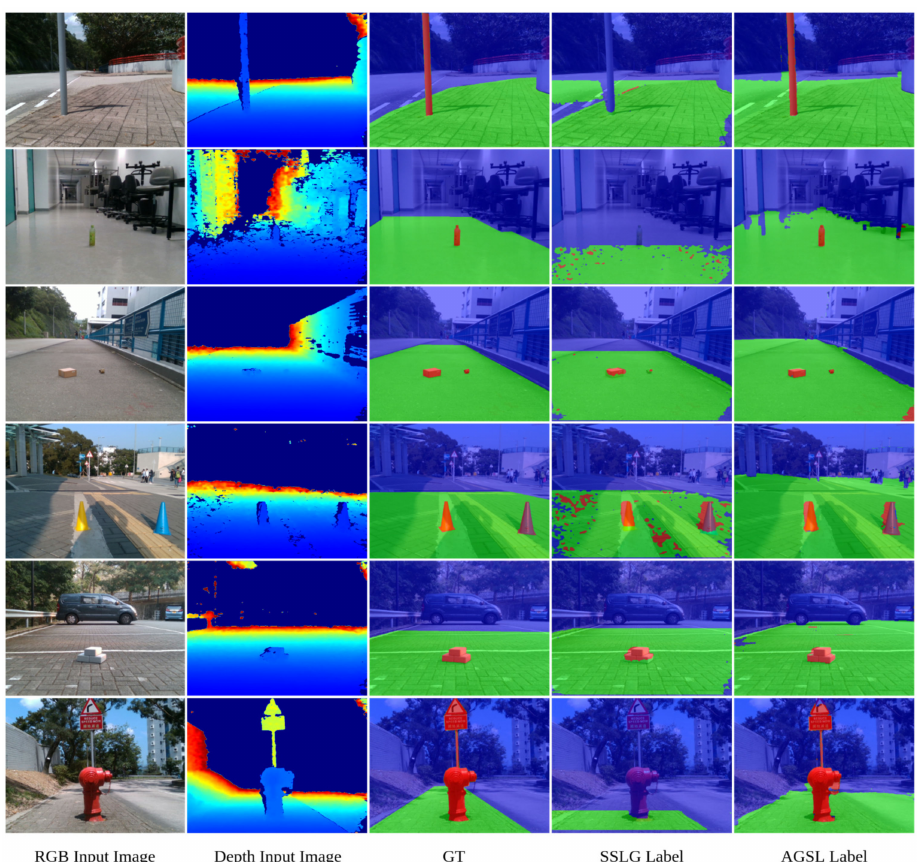
Figure 4. The comparison of the segmentation results between GT (manual labels), SSLG labels, and AGSL labels, respectively. The blue area denotes the unknown area, the green area denotes the drivable area, and the red area denotes road anomalies. The figure is best viewed in color. Table 1. The comparison of the segmentation results (%) between SSLG labels, SSLG++ (our reim-